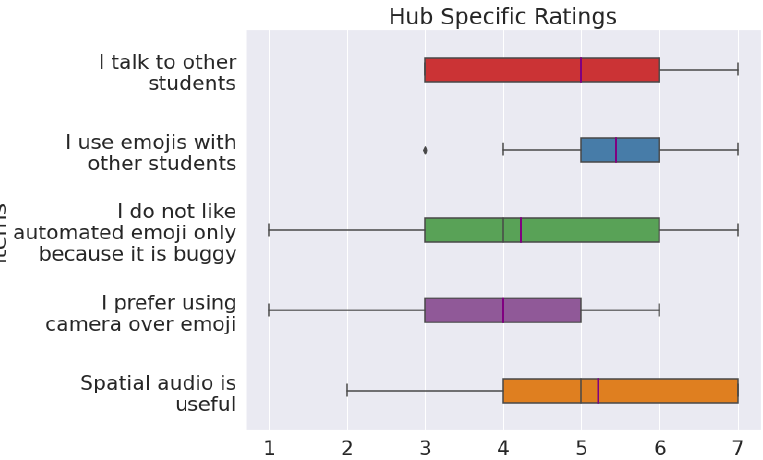
Figure 9. Hub Specific Ratings: student rating scale from 1 to 7 (strongly disagree to strongly